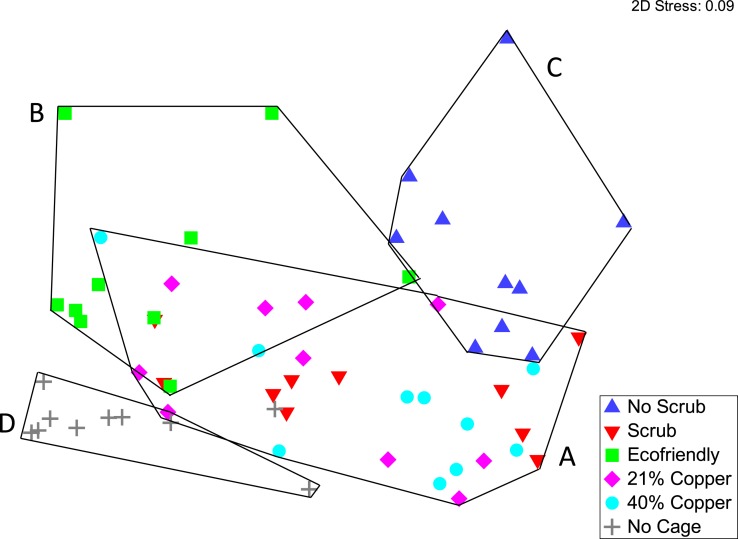
Community composition of settlement tiles.Nonmetric multidimensional scaling (nMDS) of community composition among the six experimental treatments. Minimum convex polygons and associated letter groupings (i.e., A, B, C, D) indicate differences among treatments according to the PERMANOVA and subsequent pairwise comparisons.